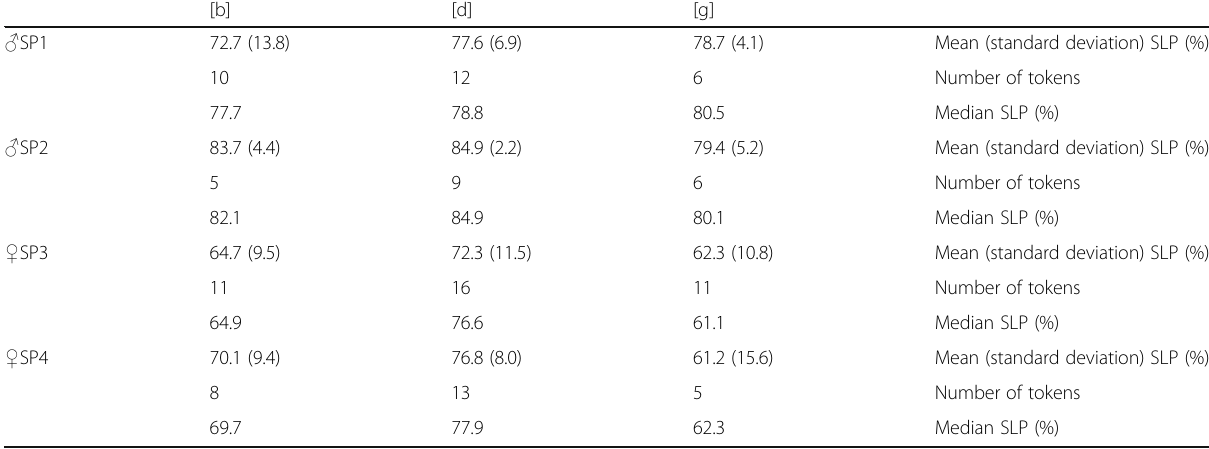
Table 3 Mean (standard deviation) SLP, number of tokens and median